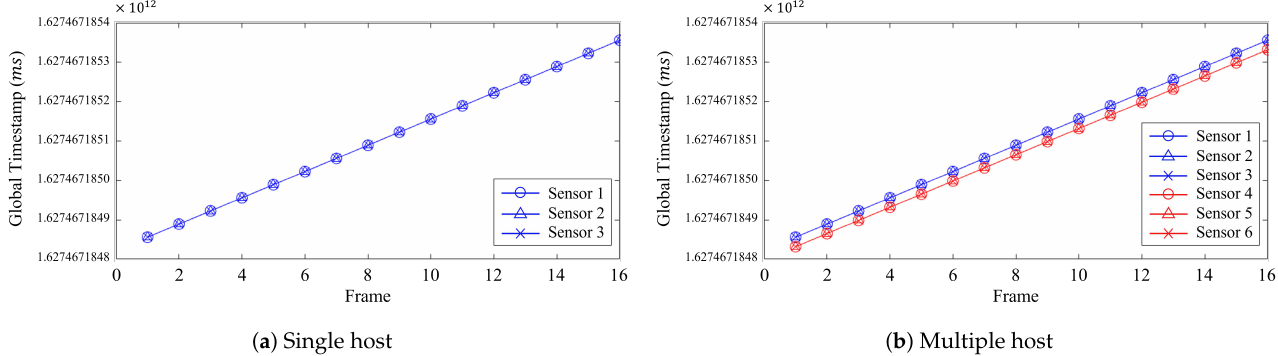
Figure 5. The global timestamps of the three cameras connected to ( a ) a single host and ( b ) six cameras connected to two